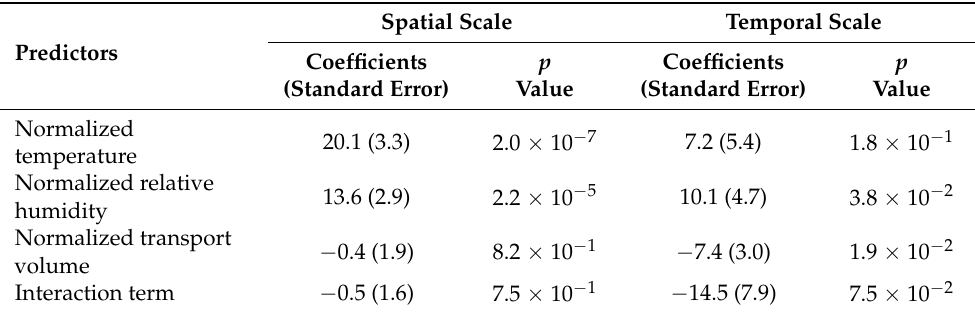
Figure 3. Initiating area of seasonal influenza A(H3N2) in southern China during summer season: ( A ) hierarchical clustering for provinces based on epidemiological distance; ( B ) geographical map of the three epidemiological regions identified in ( A ); ( C ) effective distance against lag of onset time from “Lingnan” region for influenza A(H3N2) epidemic; ( D ) mean genetic distance from the initiating “Lingnan” region for different provinces in southern China. Dark line is the linear fit line, and error bar represents the standard deviation. Table 3. Regression analysis between onset time and temperature, relative humidity, and transporta- tion of seasonal influenza A(H3N2) epidemics on spatial and temporal